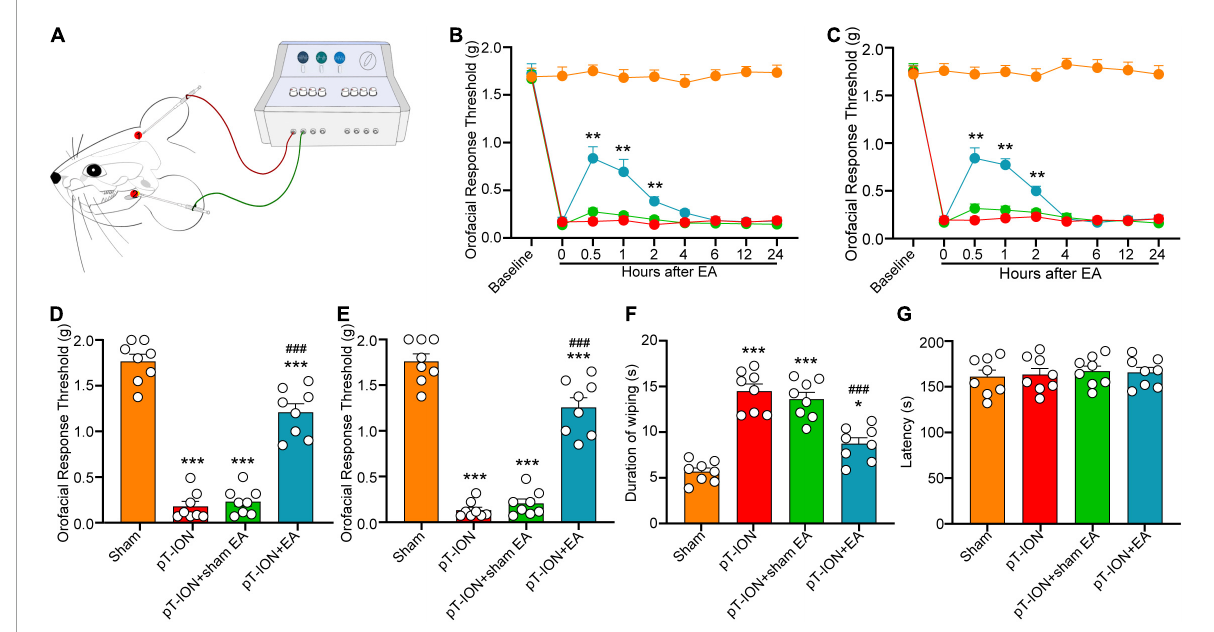
FIGURE3 Electroacupuncture (EA) alleviates pT-ION-induced nociceptive abnormalities. (A) Schematic diagram of the EA procedure. EA acupuncture points (GV20 and ST7) are indicated by red points. Immediate analgesia caused by EA was measured after the first treatment on day 7 after modeling. Primary mechanical hyperalgesia was assessed in area V2 (B) , and secondary mechanical hyperalgesia was assessed in area V3 (C) , with peak analgesia 0.5 h after EA treatment. On day 21 after pT-ION surgery (day 14 after EA every 2 days), the analgesic effect of EA is shown as an increased primary mechanical pain threshold (D) and secondary mechanical pain threshold (E) in response to von Frey stimulation and a decreased wiping duration in response to acetone stimulation (F) . EA does not affect the latency to fall in the rotarod test (G) . N = 8 mice/group, * P < 0.05, ** P < 0.01, and *** P < 0.001 vs. naive group; ### P < 0.001 vs. pT-ION group, (B,C) two-way ANOVA and Tukey’s test, (D–G) one-way ANOVA and Tukey’s test.